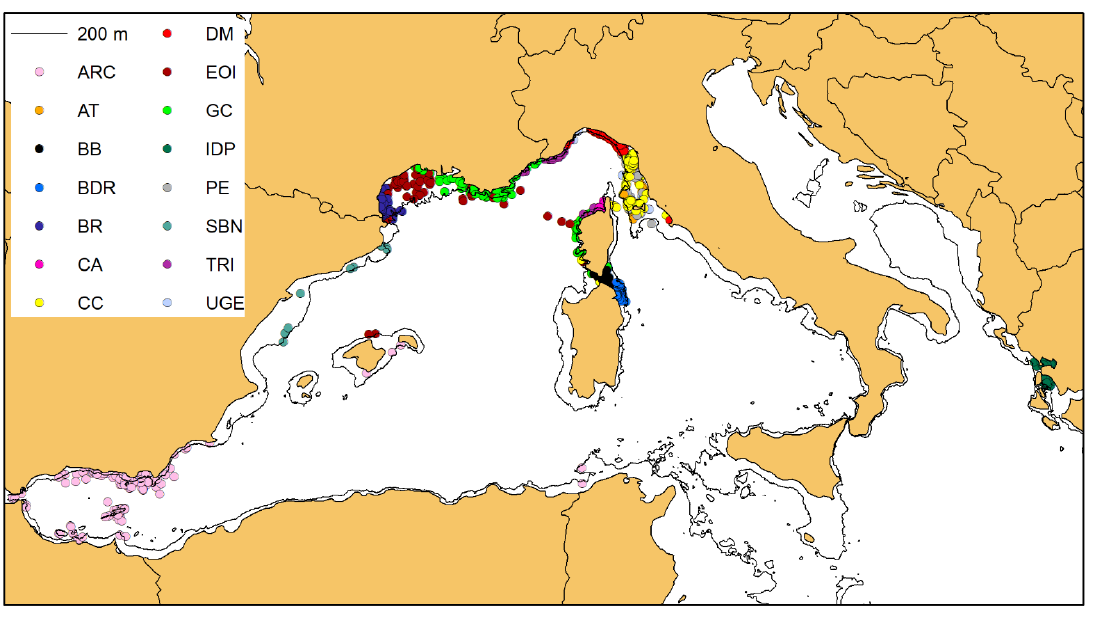
Figure 2. Sampling tracks implemented by each research group involved in the different study areas (see also Tables 1 and 2). The dark line marks border of the continental shelf (200 m isobath) in all the maps.